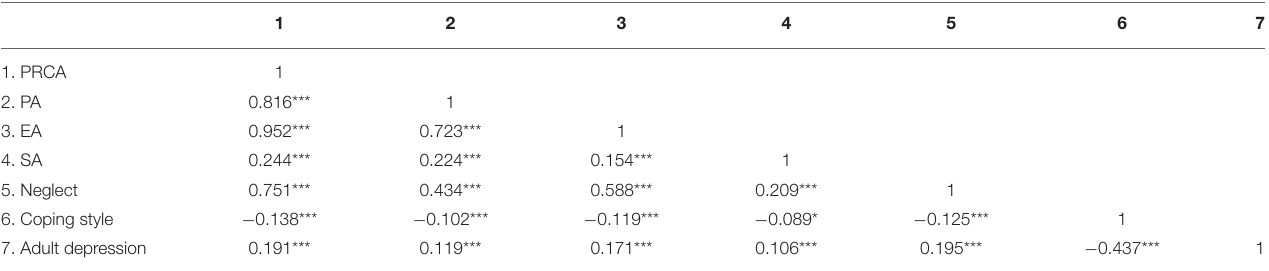
TABLE 1 | Partial correlation of various variables after controlling potential age